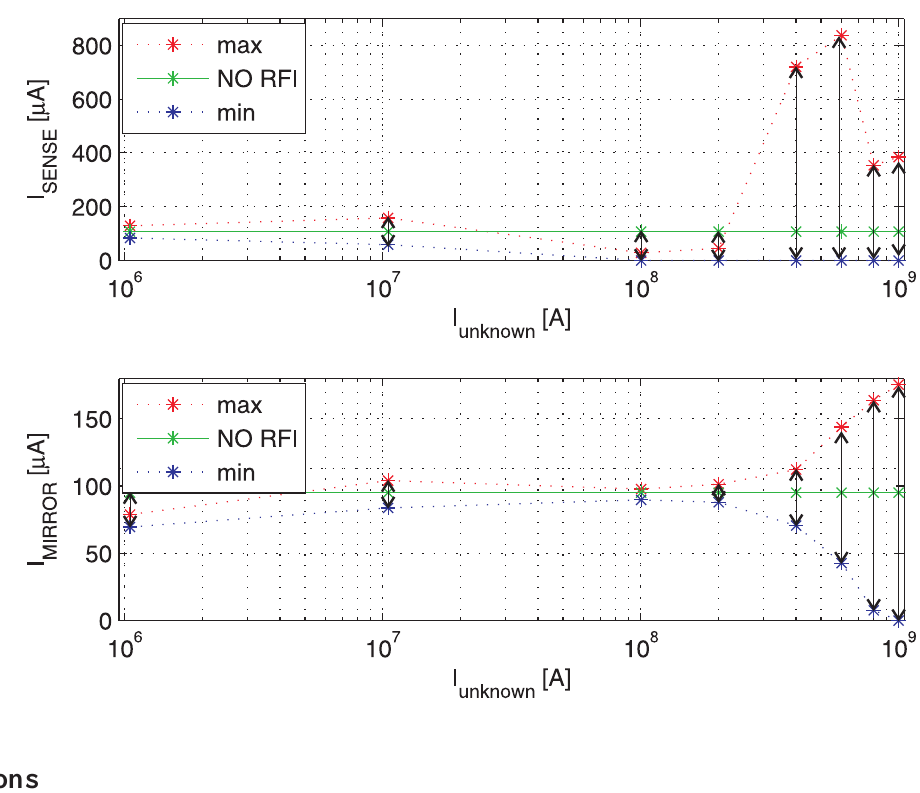
Figure 13. Maximum and minimum current-sensing of the traditional SenseFET current sensor ( I ) and the new sensor based on the Miller effect ( I SENSE